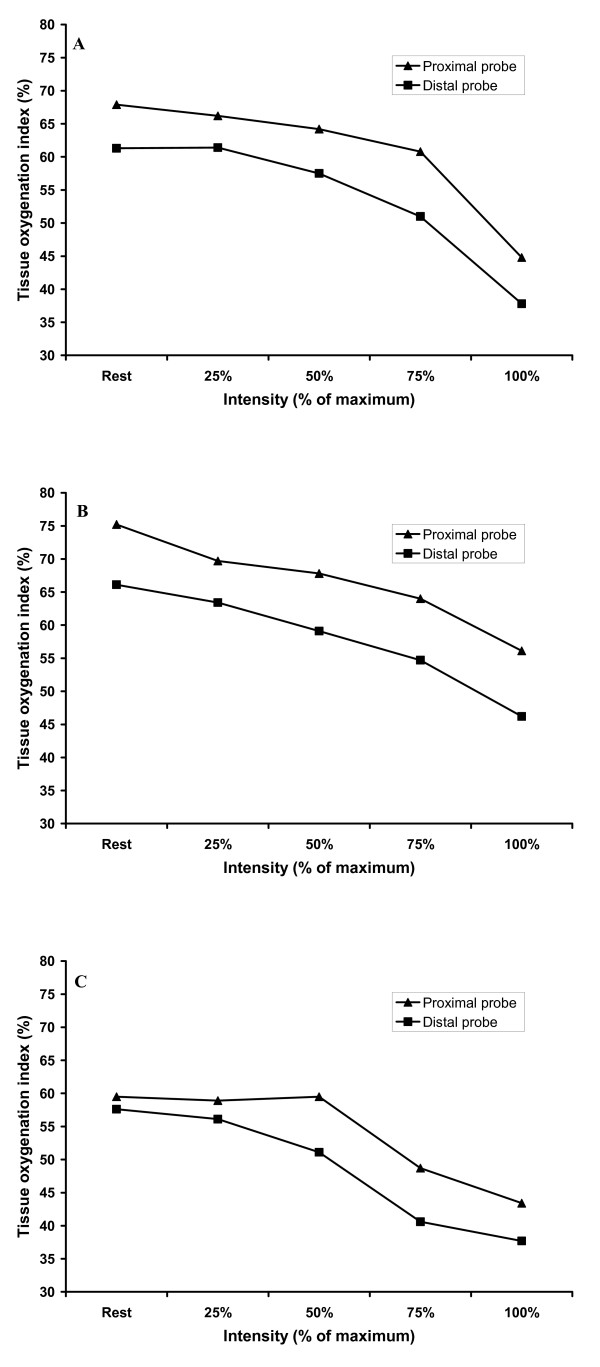
Representative tracing of a single participant for proximal and distal TOI values for each mode of exercise where, A: 1 leg KE; B: 2 leg KE; C: cycling.